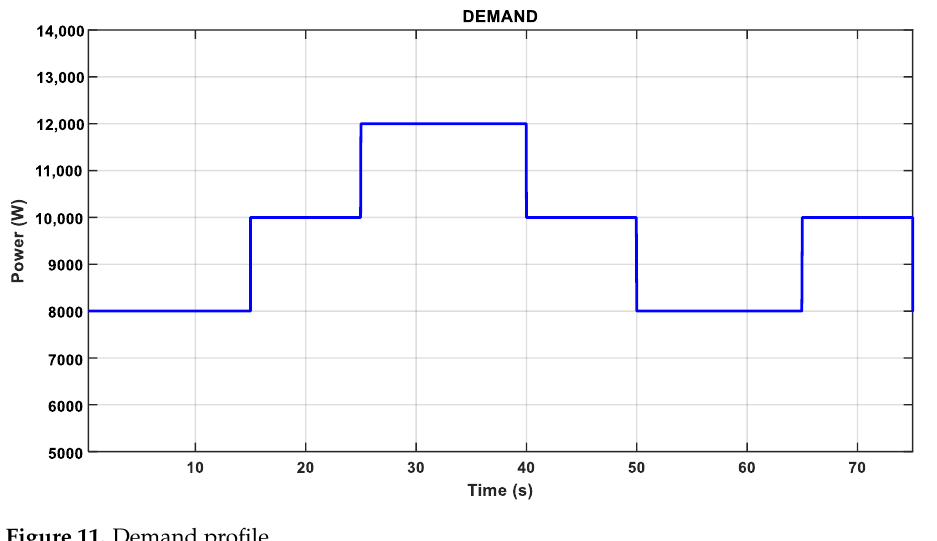
Figure 11. Demand profile.